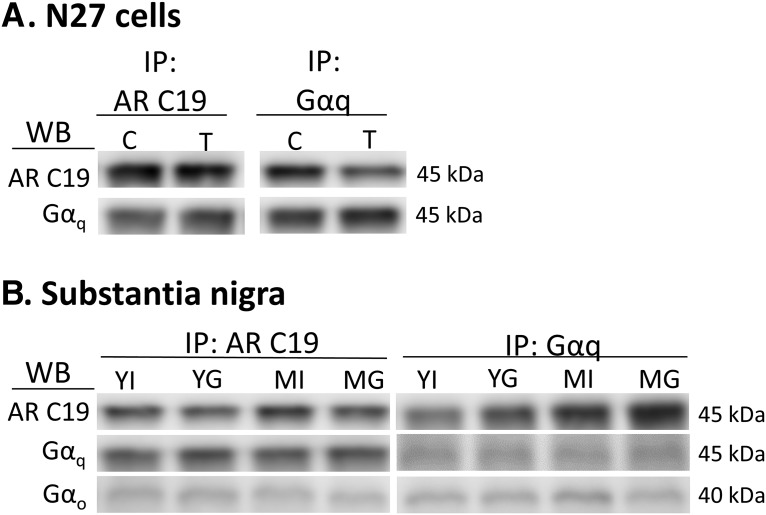
Coimmunoprecipitation (IP) of the AR45-G protein complex. Whole-cell lysates of N27 cells treated with either vehicle or 100 nM testosterone (A) and substantia nigral tissue from young and middle-aged male rats that were either gonadectomized or gonadally intact (B) were used. AR CTD-containing AR45 proteins were immunoprecipitated and then immunoblotted (WB) for Gαq and Gαo. In a reciprocal fashion, Gαq-containing proteins were immunoprecipitated and then immunoblotted for AR45. In N27 cells, bands corresponding to AR45 (AR-C19) and Gαq were detectable. In substantia nigral tissue, bands corresponding to AR45 (AR-C19), Gαq, and Gαo were observed. C, control; T, testosterone; YI, young gonadally intact male rats; YG, young GDX male rats; MI, middle-aged gonadally intact male rats; MG, middle-aged GDX male rats. n = 4 per treatment group.